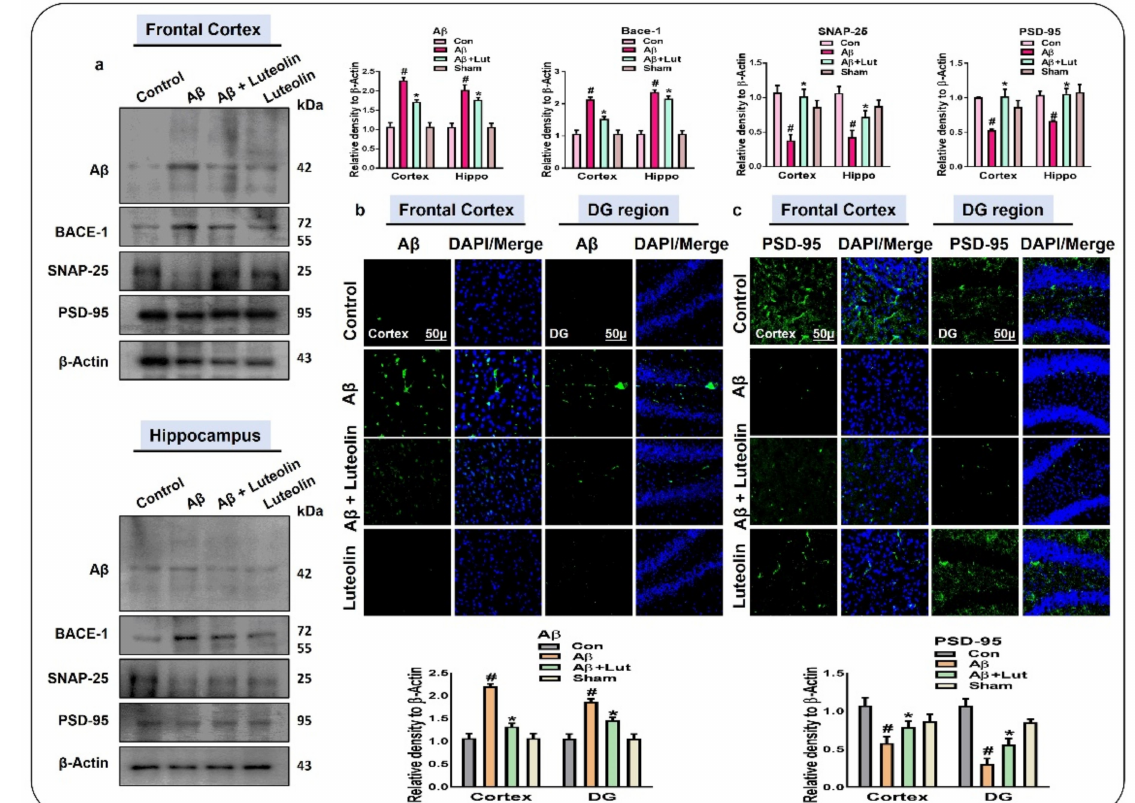
Figure 5. Luteolin improved the synaptic dysfunction and reduced the accumulation of A β in the brains of A β 1 – 42 -treated mice. ( a ) Western blot results of A β , BACE-1, PSD-95, and SNAP-25 in the cortex and hippocampus of experimental mice. β -actin was used as a loading control. ( b,c ) Immunofluorescence images of A β and PSD-95 in the frontal cortex and DG region of the hippocampus of experimental mice. Values are given from three independent experiments. Magnification 10 × . Scale bar 50 µ m. For the statistical analysis, Graph Pad Prism 5 software was used, and one-way ANOVA and posthoc multiple comparison tests were employed. * p < 0.05 represents control versus A β -treated mice, # p < 0.05 represents A β + Luteolin-treated